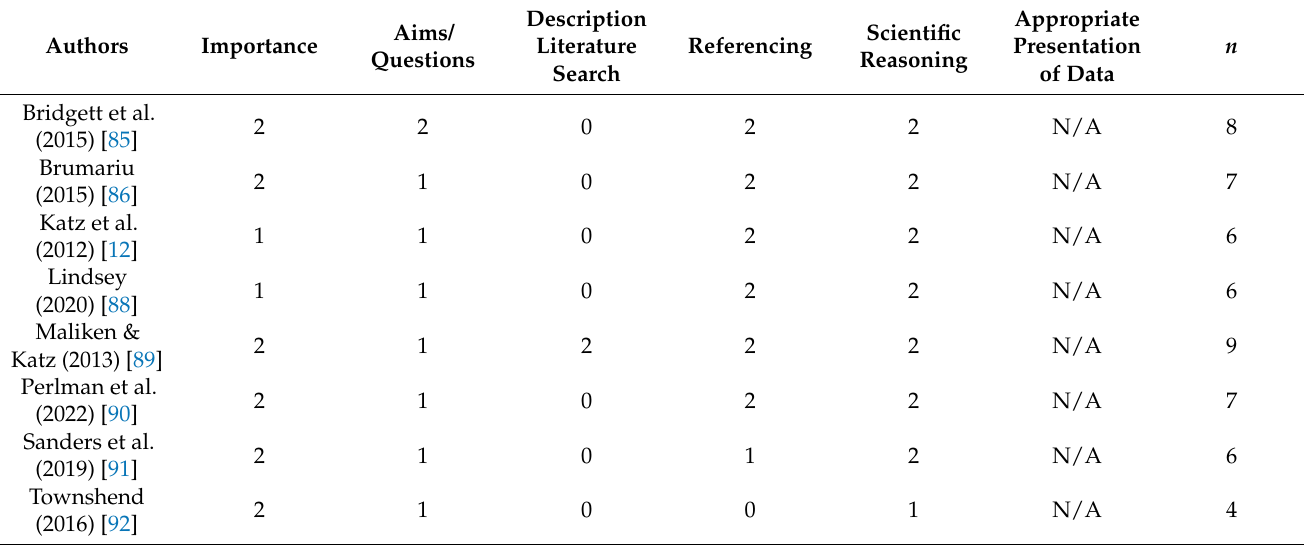
Table A2. Quality Estimation of the Included Narrative Reviews Using the SANRA.